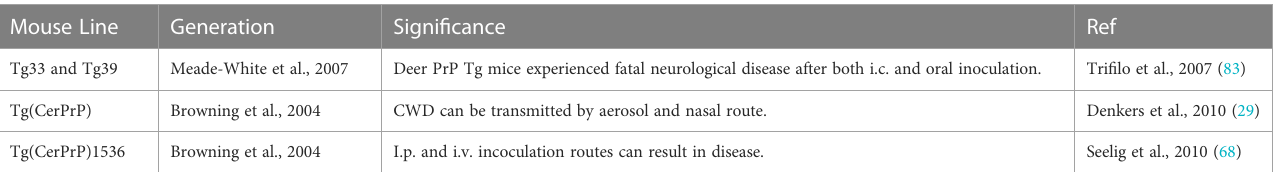
TABLE 3 Routes of transmission.